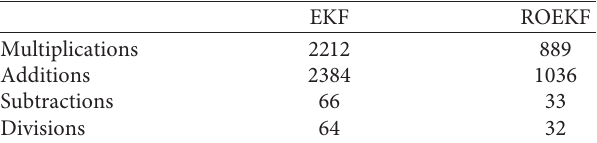
Table 2: Comparison of math functions in EKF and ROEKF methods.